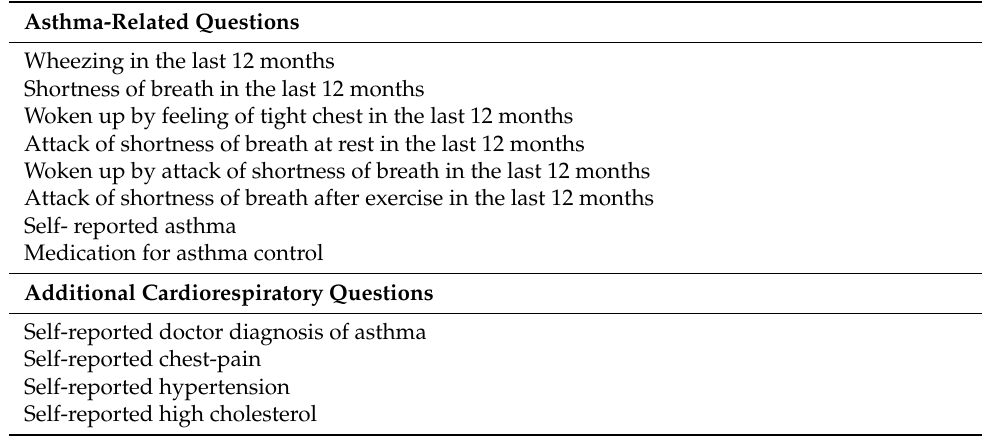
Table 1. Cardiorespiratory questions included in the